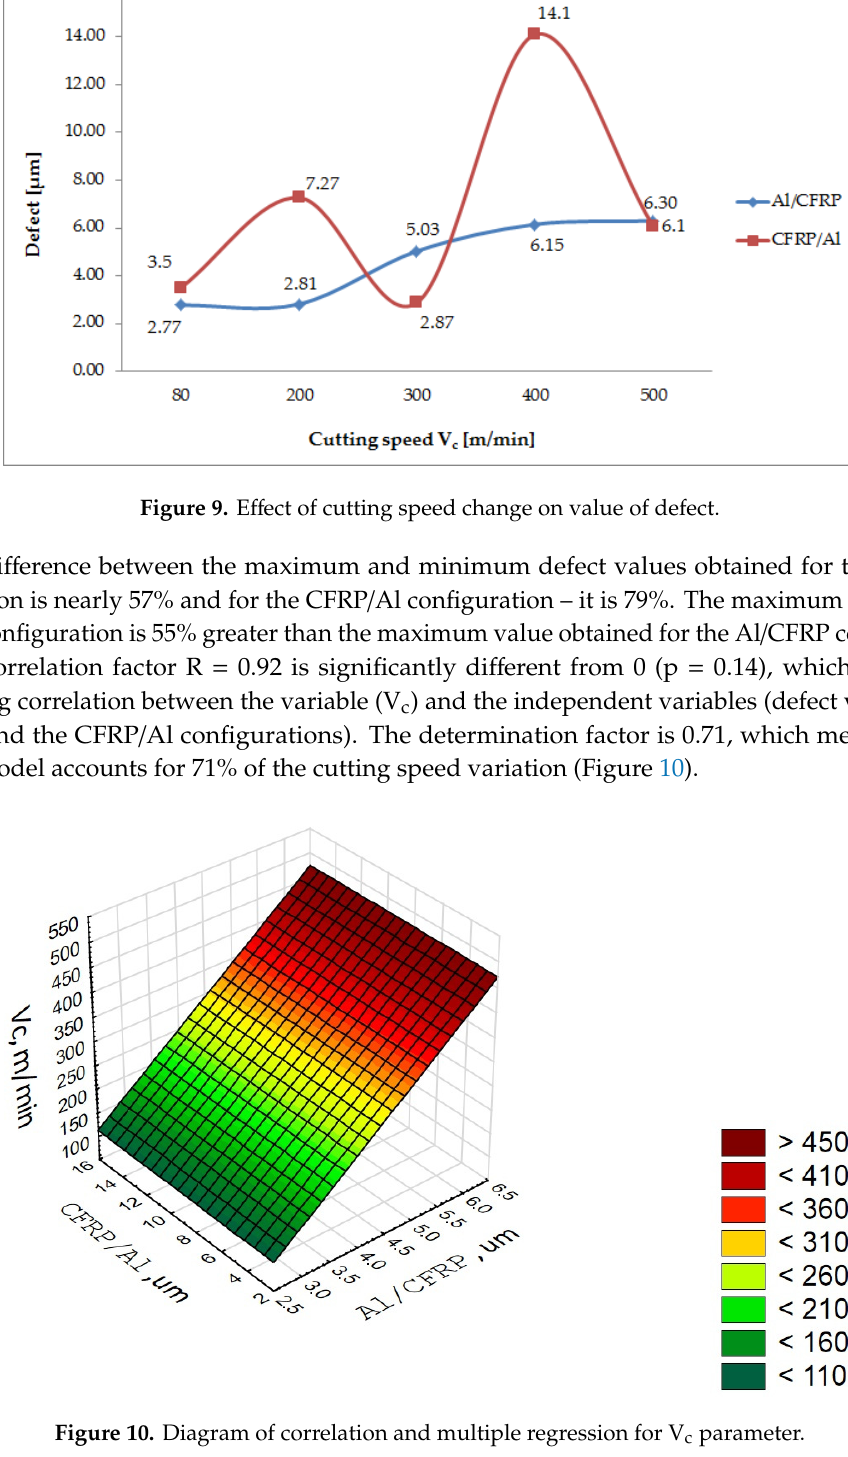
Figure 10. Diagram of correlation and multiple regression for V c parameter.